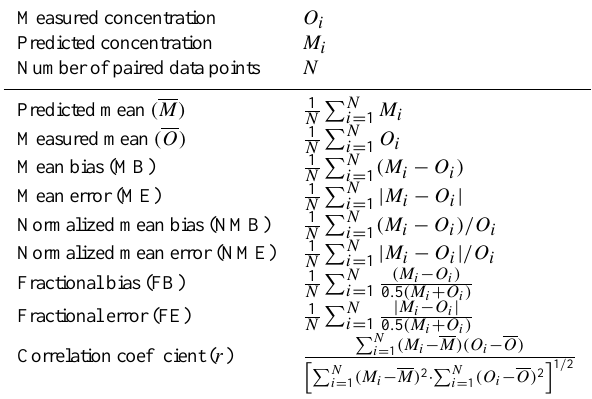
Table 2. Definitions of model performance statistics (Chen et al.,